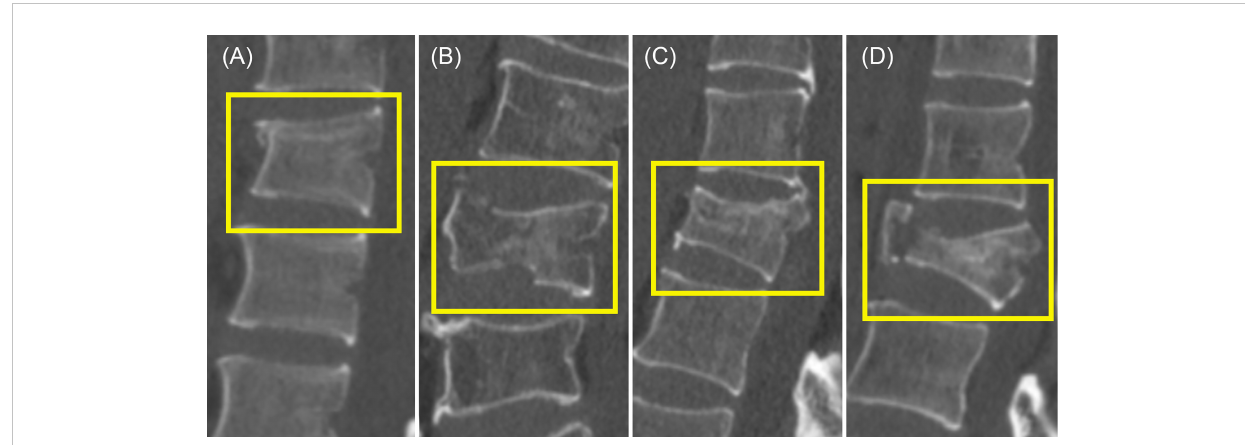
FIGURE 1 Examples of type A1, A2, A3, and A4. (A) Type A1. Only the upper endplate was involved. (B) Both the upper endplate and the lower endplate were involved. (C) Both the upper endplate and the posterior wall were involved. (D) The upper endplate, the lower endplate, and the posterior wall were